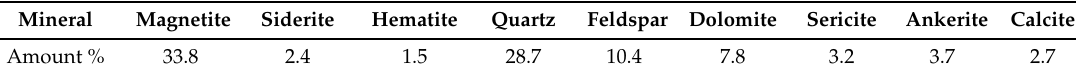
Table 2. Mineral components of raw ores.